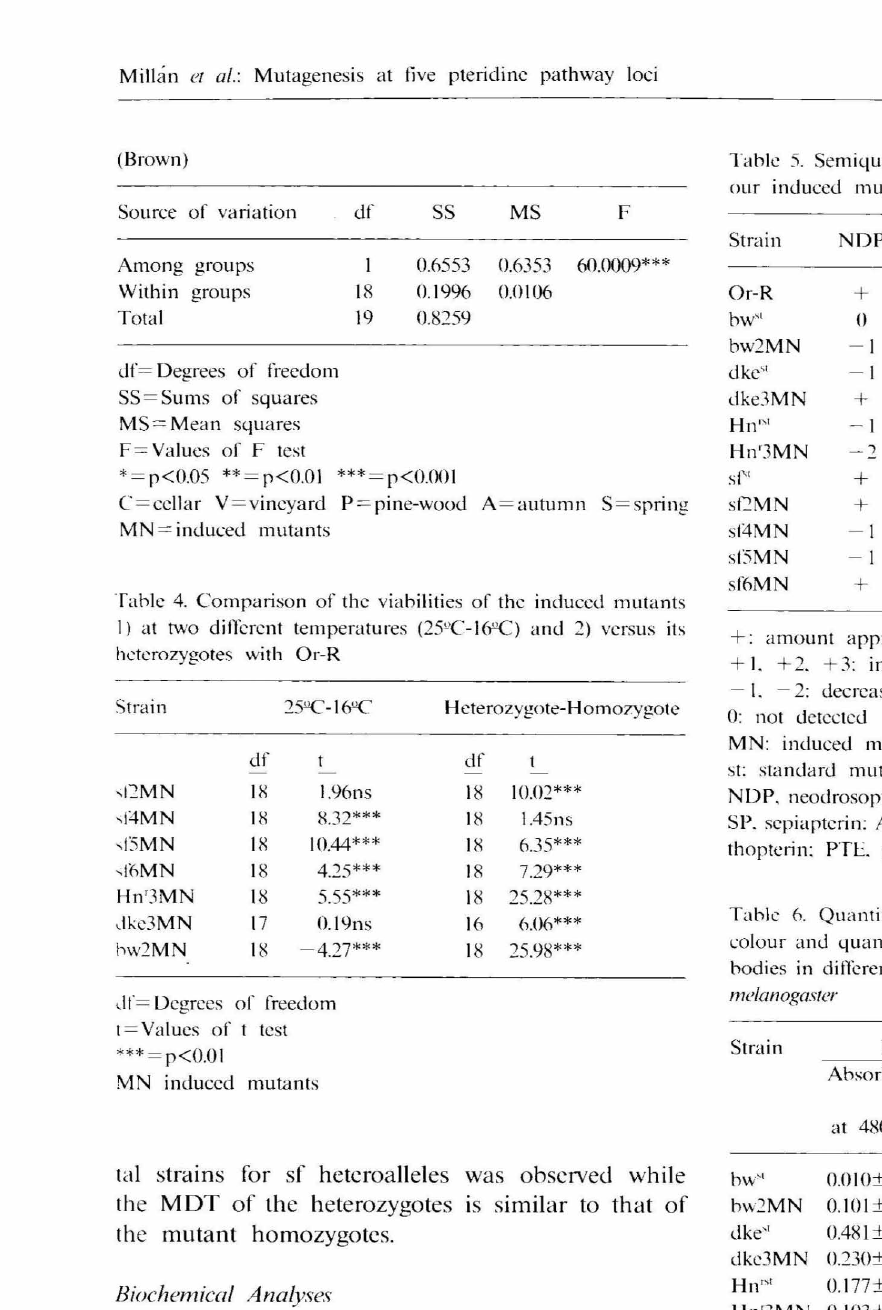
Table 6. Quantitative estimation of the red pigment of eye colour and quantitative estimation of isoxanthopterin in male bodies in difTerent standard and induced mutants of Drosopiia melanogasler Strain Red